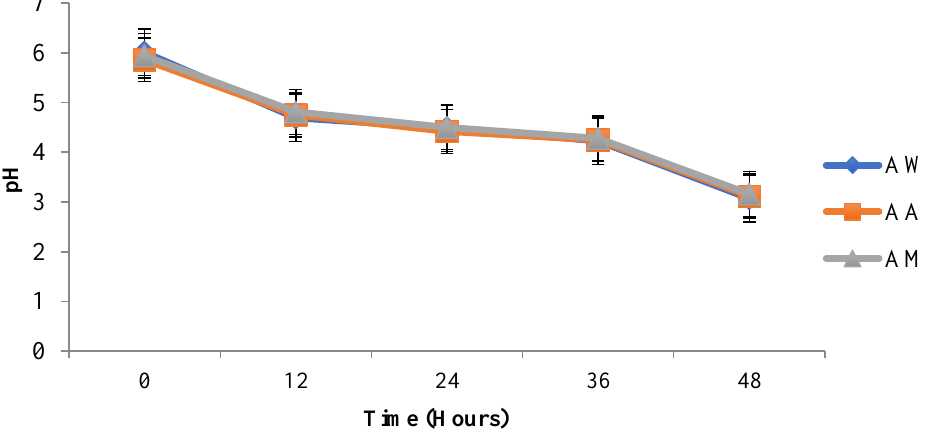
Figure 9. Effect of L. fermentum on the pH of the synbiotic beverages. The acidity of the beverages increased as time progressed. AW and AA beverages had the highest acid content of 3.60 mg/mL after 48 h (Figure 10). Key: AM—baobab fruit pulp and milk beverage; AA—baobab fruit pulp and apple juice beverage; AW—baobab fruit pulp and apple juice